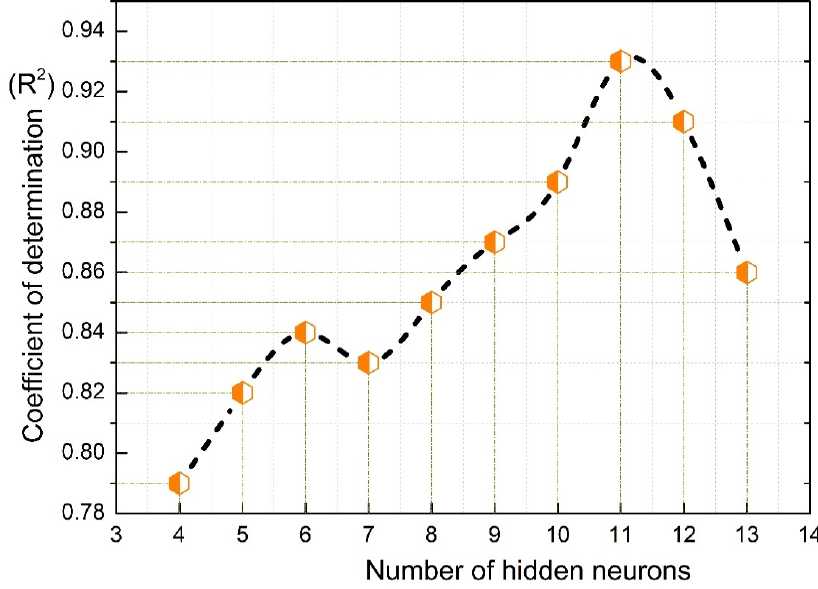
Figure 8. Number of hidden neurons impacts the ANN network: Coefficient of determination R2 has the largest value (0.96) when the number of hidden neurons is 11.